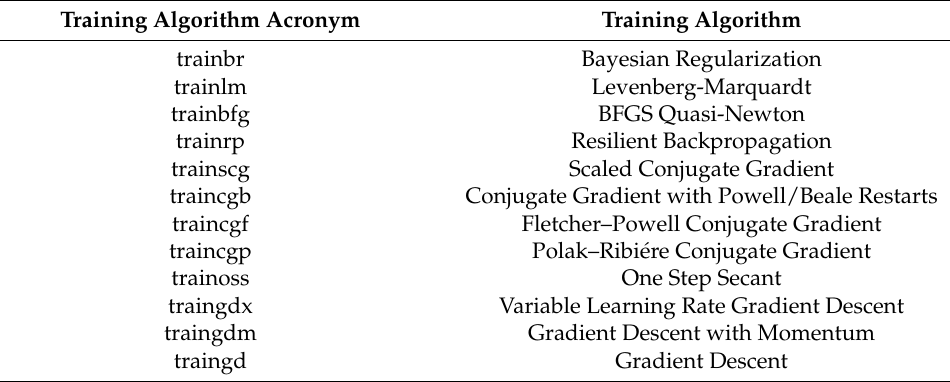
Table 4. Explanation of training algorithm